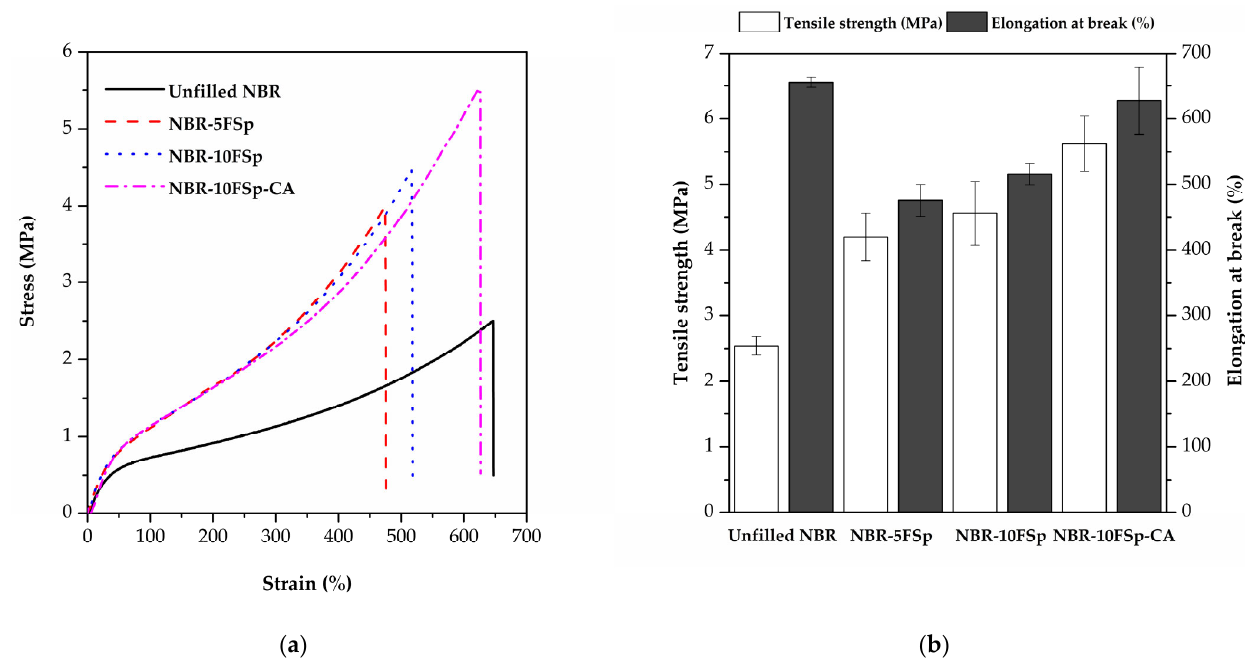
Figure 6. Mechanical properties of NBR/FSp and NBR/FSp/CA composites showing ( a ) Stress–strain curves and ( b ) Tensile strength and percentage of elongation at break. Table 4. Mechanical properties of NBR/FSp and NBR/FSp/CA composites.